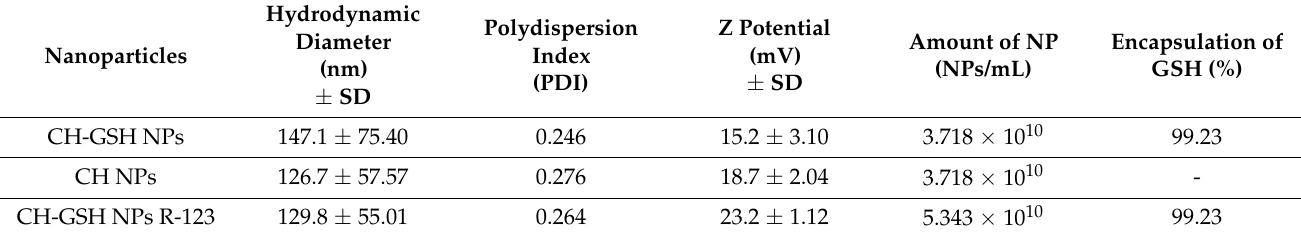
Table 1. Characterization